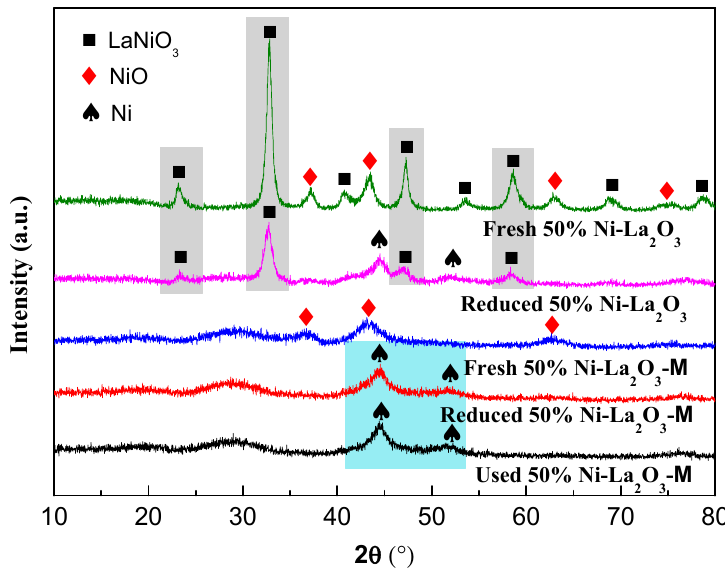
Figure 2. X-ray di ff raction (XRD) patterns of 50% Ni–La 2 O 3 –M and 50% Ni–La 2 O 3 . Reduced catalysts were reduced at 400 ◦ C for 40 min with 20% H 2 / Ar. We used 50% Ni–La 2 O 3 –M at 300 ◦ C for 50 h in a CO 2 methanation